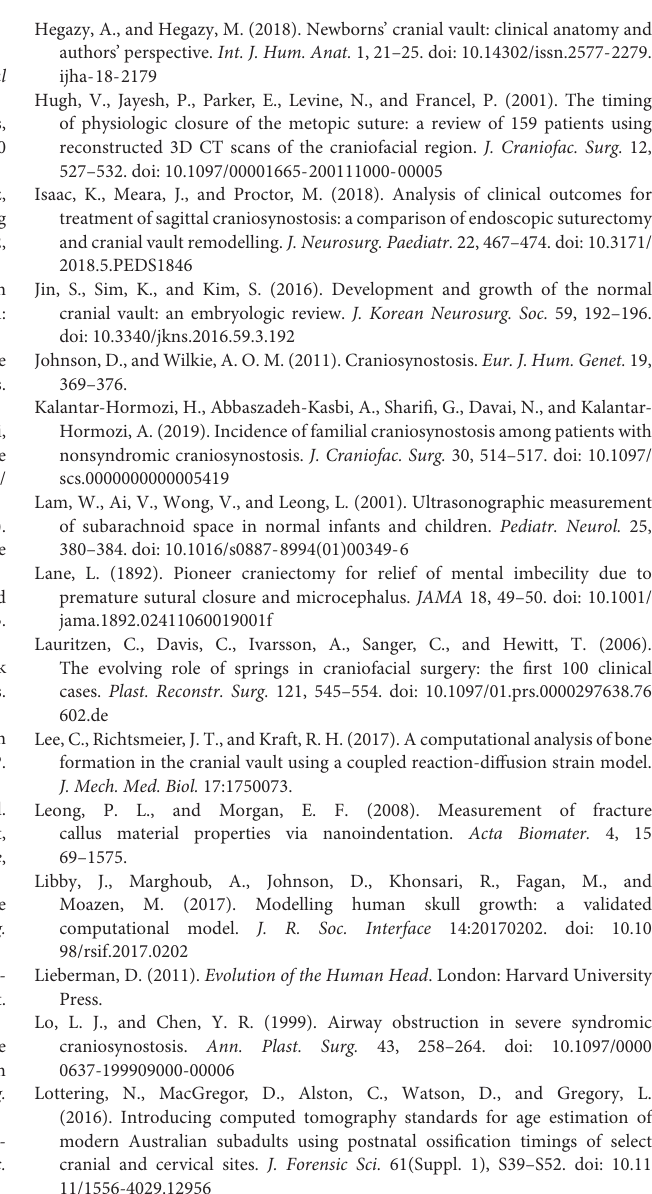
Supplementary Figure 1 | CSF elastic modulus sensitivity, contact pressure across the